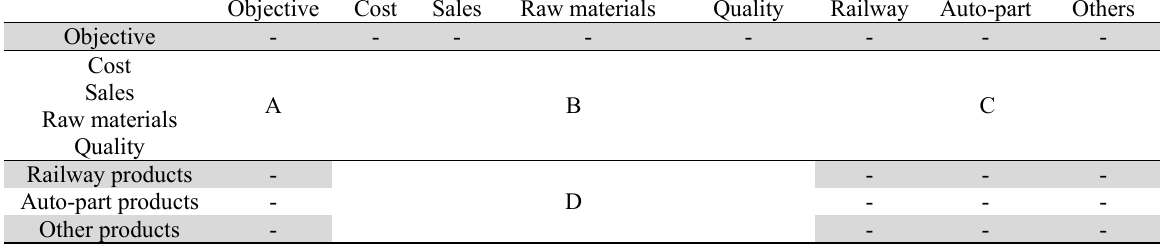
The results of super matrix used for the proposed study